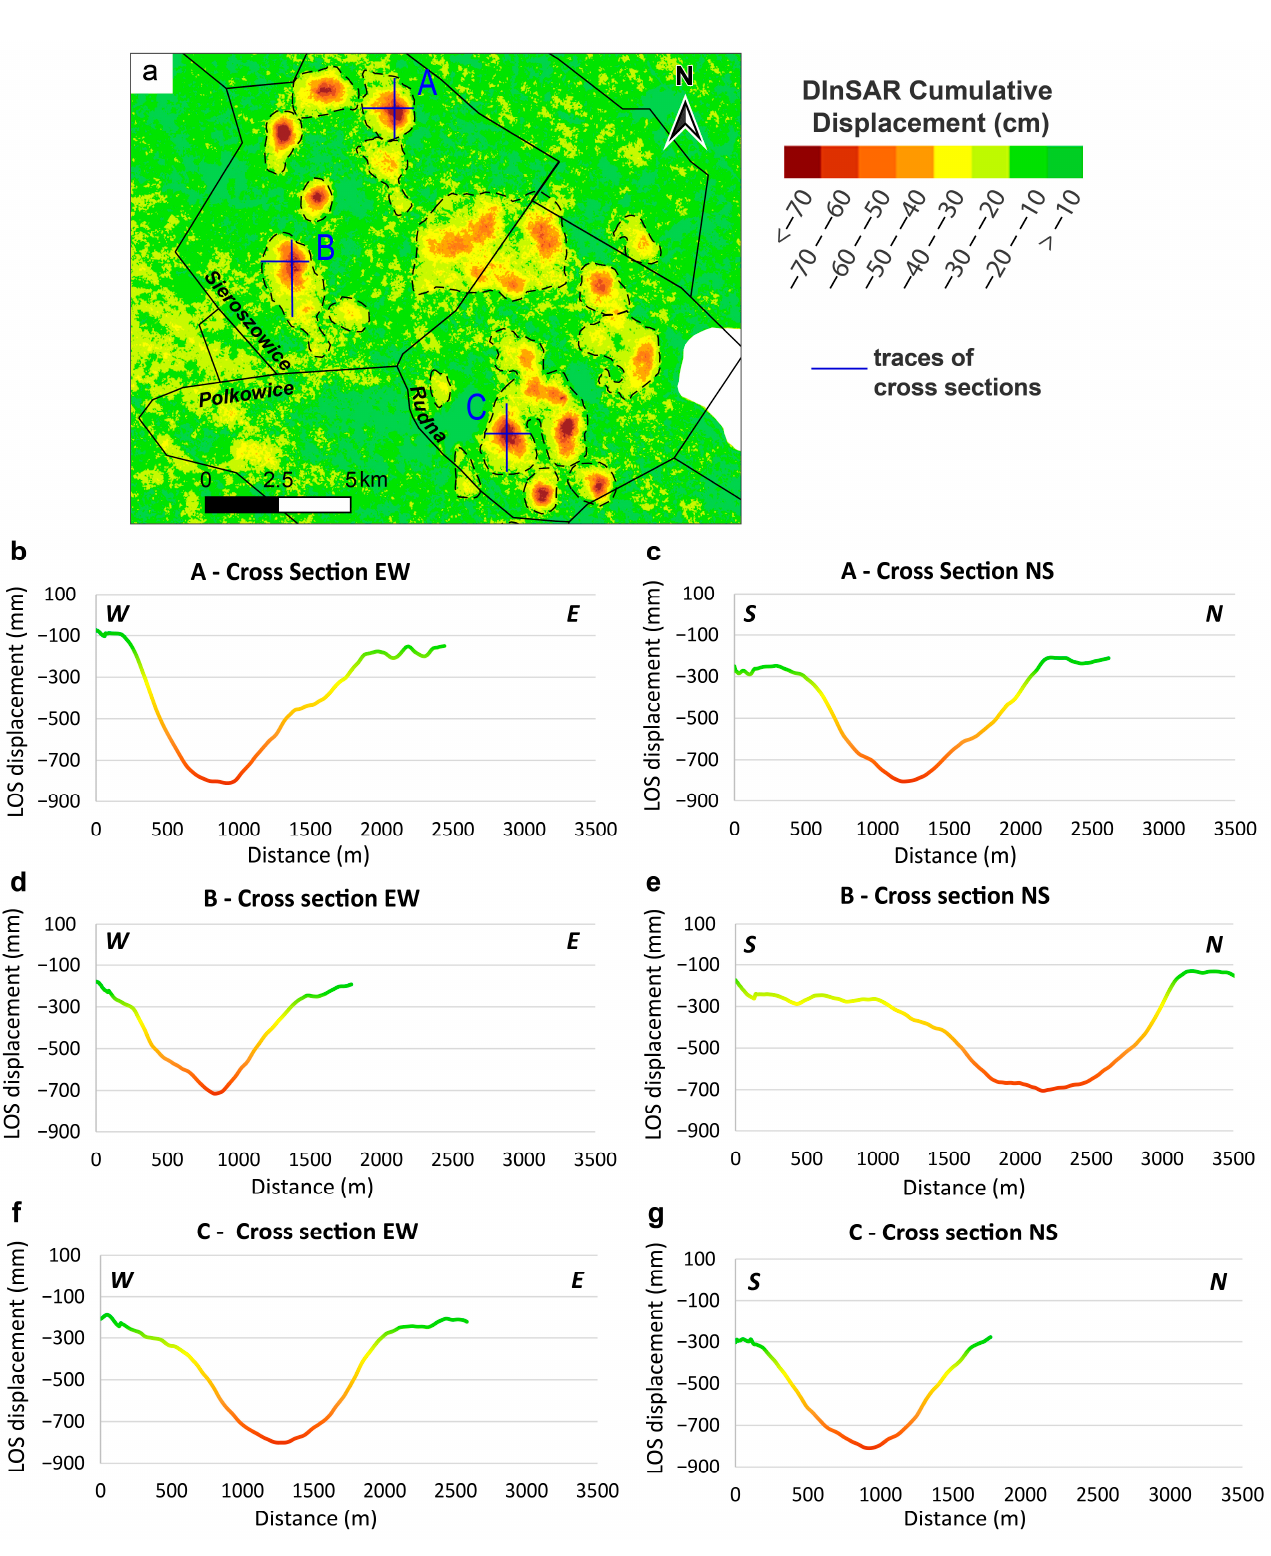
Figure 8. Cumulative displacement profiles at three subsidence troughs A, B, and C; ( a ) location of the cross sections; ( b , c ) EW and NS cross sections of subsidence trough A, respectively; ( d , e ) EW and NS cross sections of subsidence trough B, respectively; ( f , g ) EW and NS cross sections of subsidence trough C, respectively.